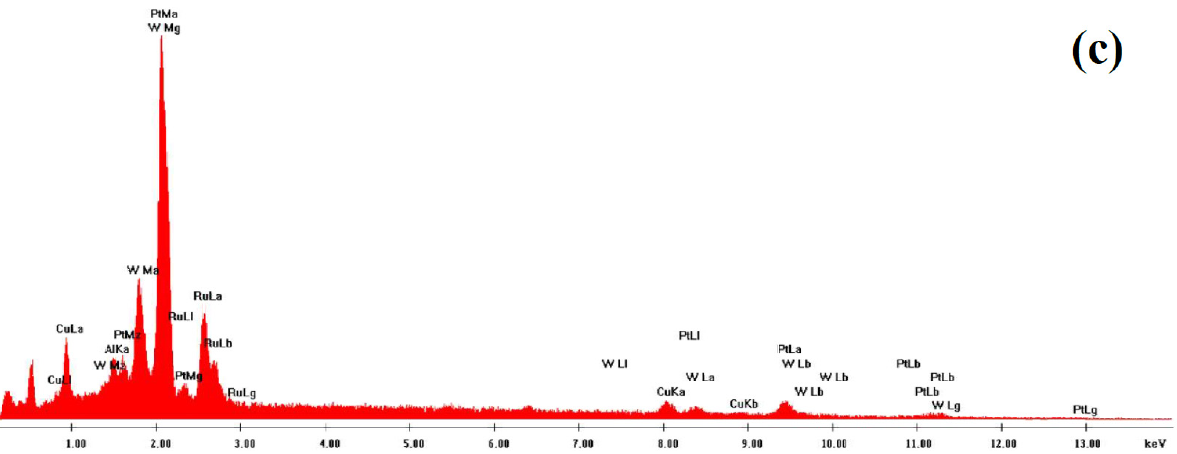
Figure 1. XRD spectrum of ( a ) the mechanically alloyed Al 66 Cu 30 (Pt 53 Ru 32 W 15 ) 4 powders; ( b ) ( c ) corresponding EDX result of the as-dealloyed